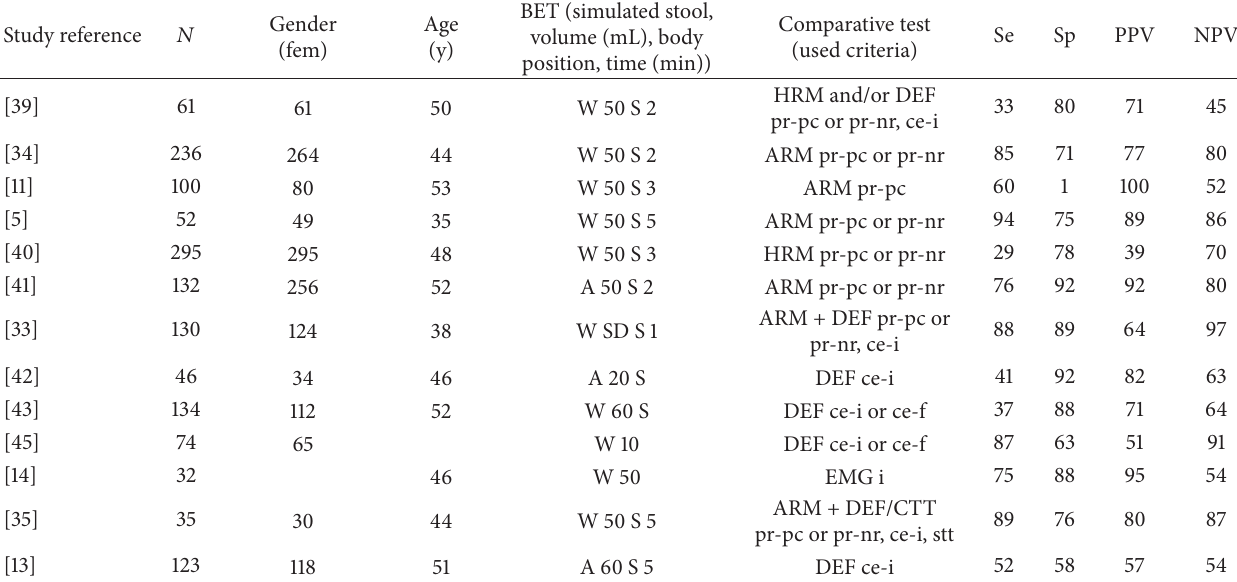
Table 2: Summary of studies with balloon expulsion test.